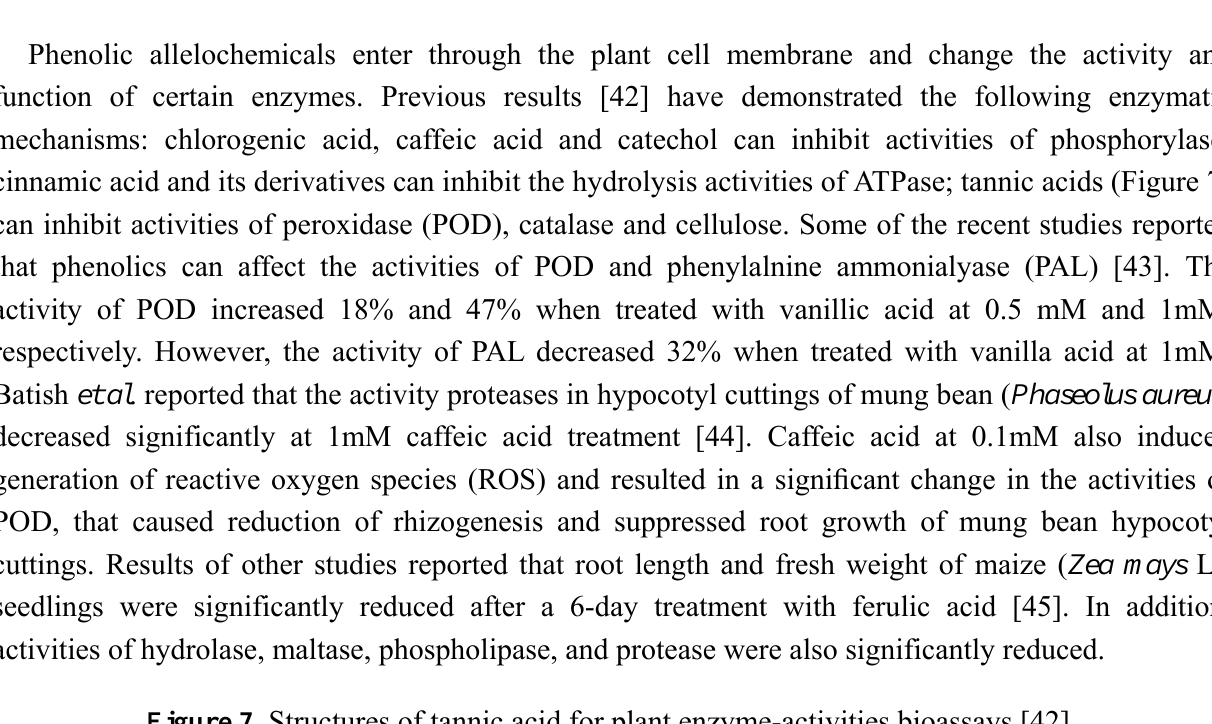
Figure 7. Structures of tannic acid for plant enzyme-activities bioassays